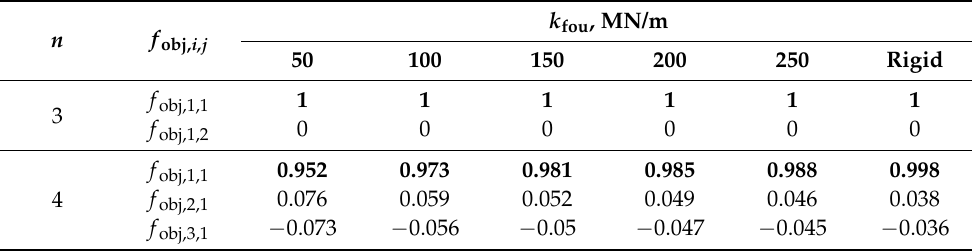
Table A8. Values f obj, i , j , [-], of the matrix f obj of object displacement forms for n = 3, 4, 8, k fou =